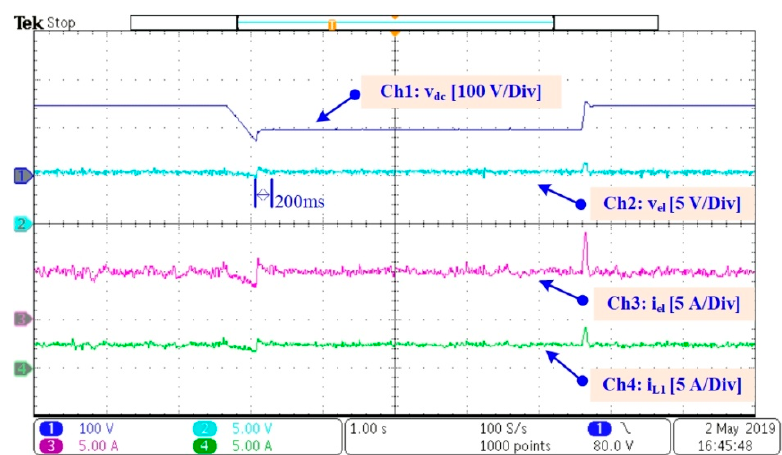
Figure 9. test from V dc = 75 V to V dc = 150 V: channel 1: DC bus voltage (V dc ), channel 2: PEM EL voltage (V el ), channel 3: PEM EL current (I el ), channel 4: first phase current (I L1 ).